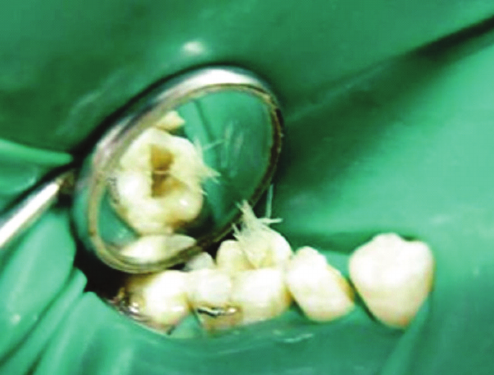
Figure 5: Intracoronal splinting with FRC.